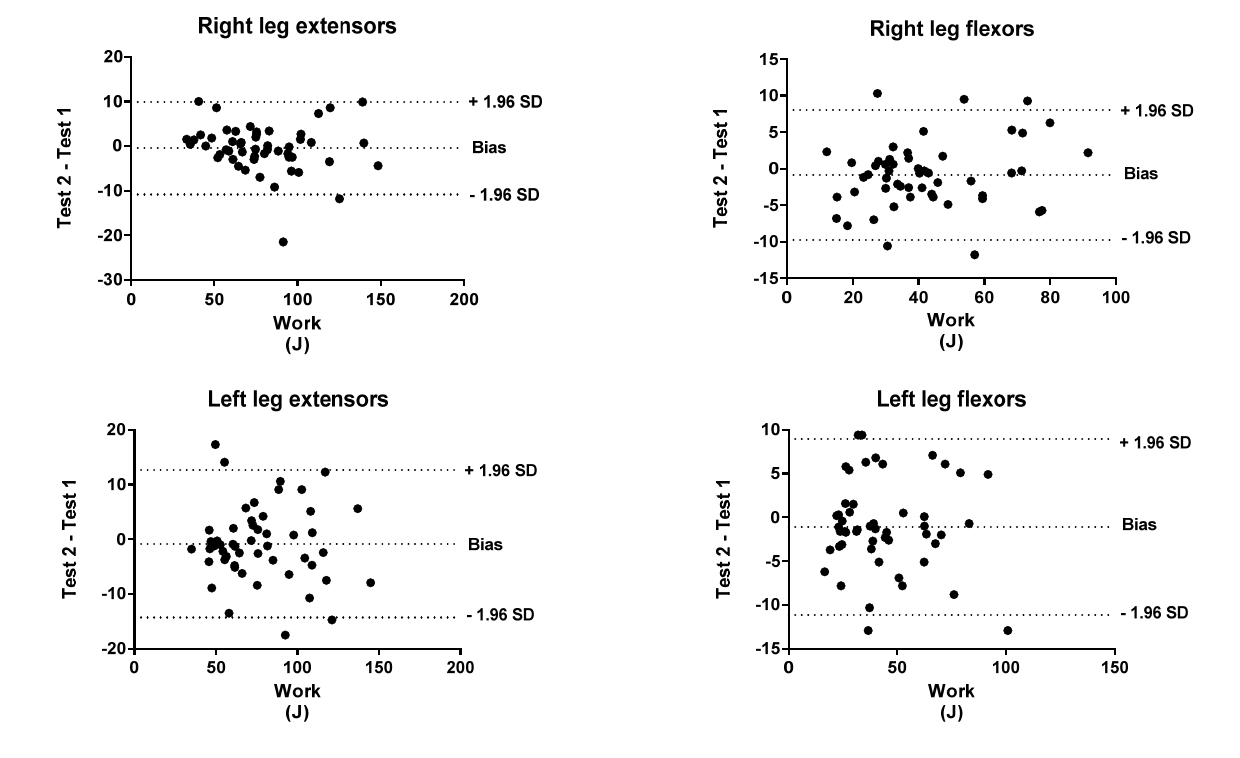
Figure 2. General Bland–Altman work analysis for Right and Left Legs in flexion and Extension.